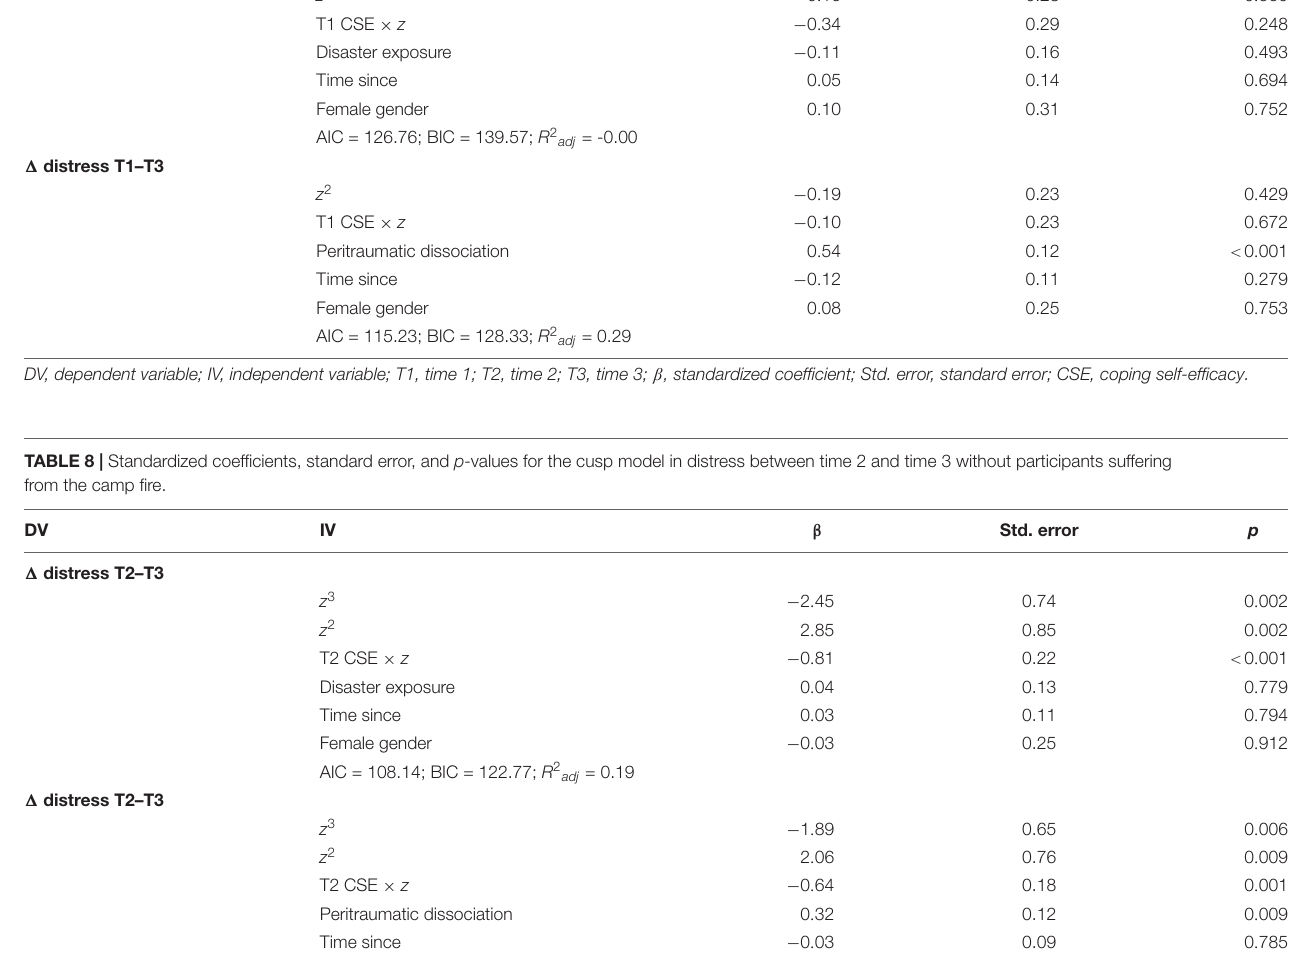
AIC = 126.76; BIC = 139.57; R 2 adj = -0.00